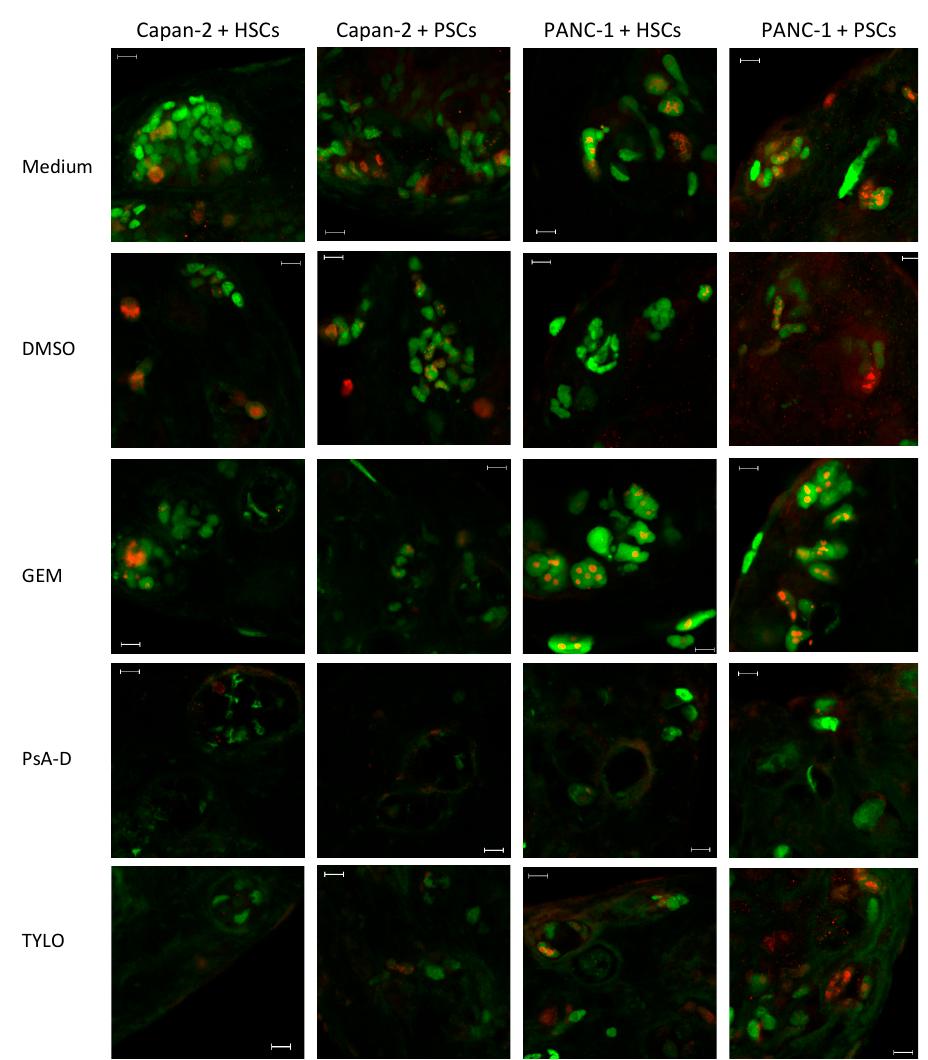
Figure 6. Optical sections demonstrating THE Ki-67 (red) and p53 (green) expression using Airyscan imaging near the edge of intact spheroids. Spheroids prepared from 500 cancer cells and 1000 hepatic stellate cells (HSCs) or pancreatic stellate cells (PSCs) in 50 µL of 0.1 mg/mL human type I collagen were grown for 4 days and then treated with the medium, 100 µM gemcitabine (GEM), 70 µM pseudopterosin A-D (PsA-D), 0.1 µM O -methyltylophorinidine (TYLO), and 0.7% DMSO as a solvent control. Scale bar: 10 µm.